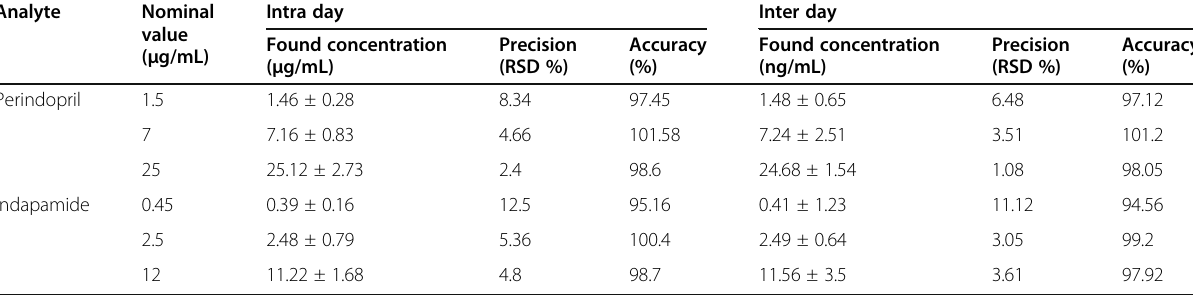
Table 3 Validation parameters results for determination of perindopril and indapamide Analyte